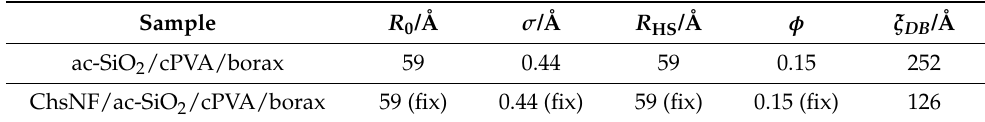
Table 1. The result of the fitting